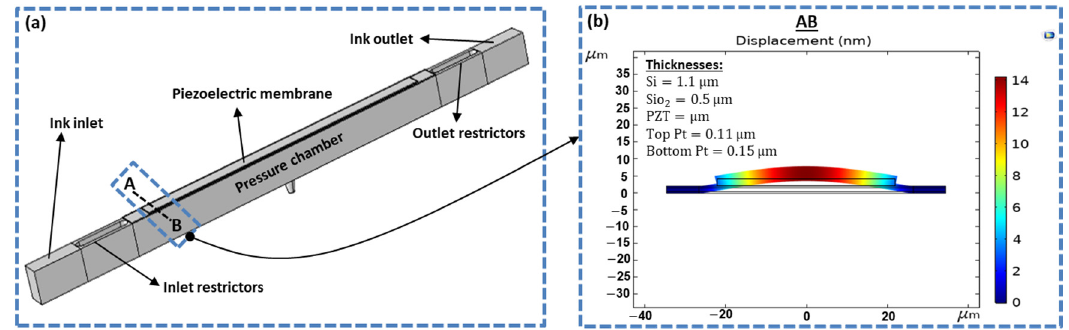
Figure 2. ( a ) Recirculating inkjet printhead; and ( b ) a displaced cross-sectional view of a piezoelectric membrane on the top of the pressure chamber.